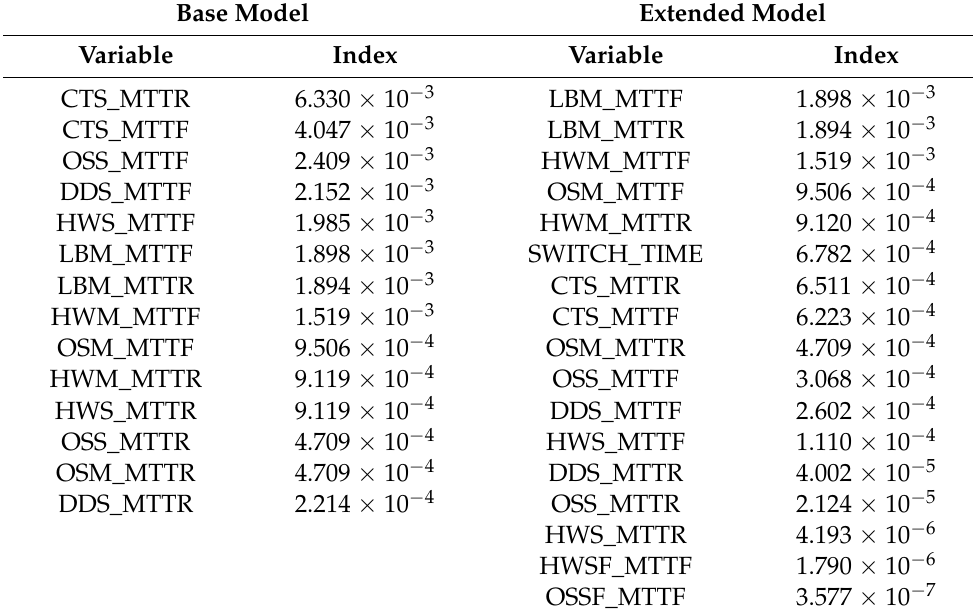
Table 8. Values resulting from the sensitivity analysis on the timed transitions of the SPN models.